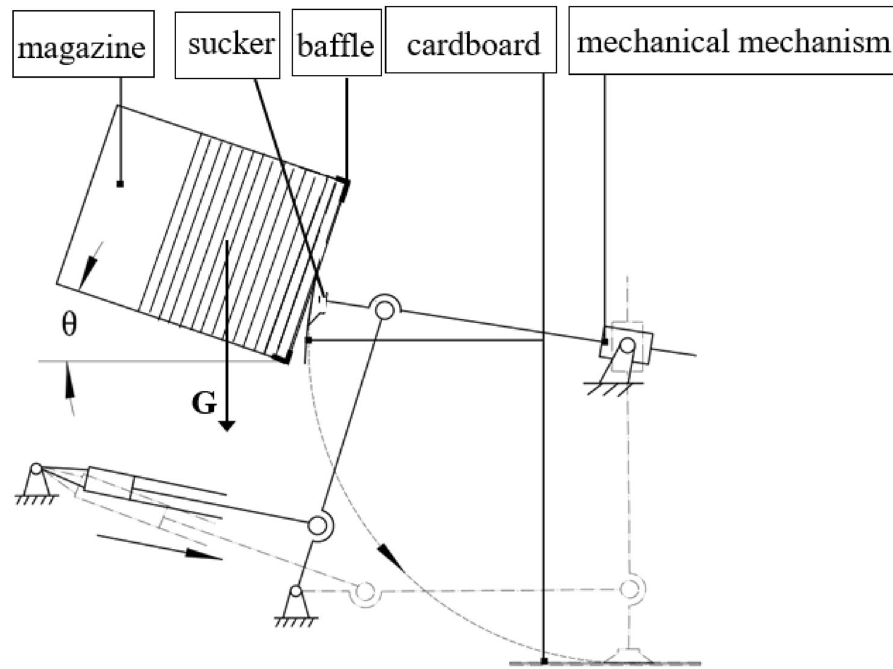
Fig. 2 Scheme of vacuum